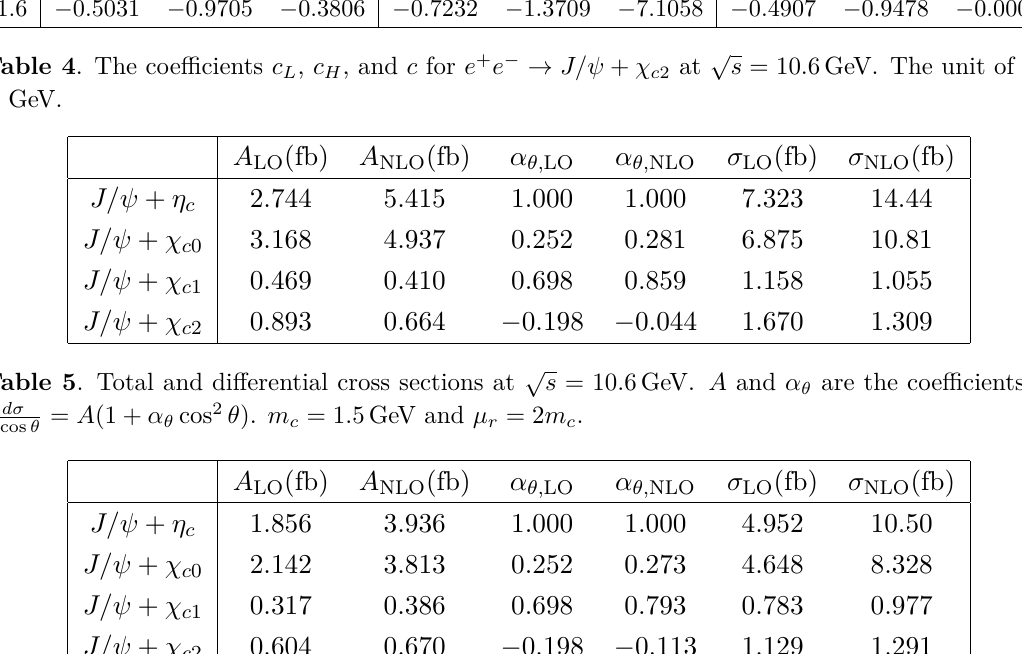
Table 6 . Total and differential cross sections at